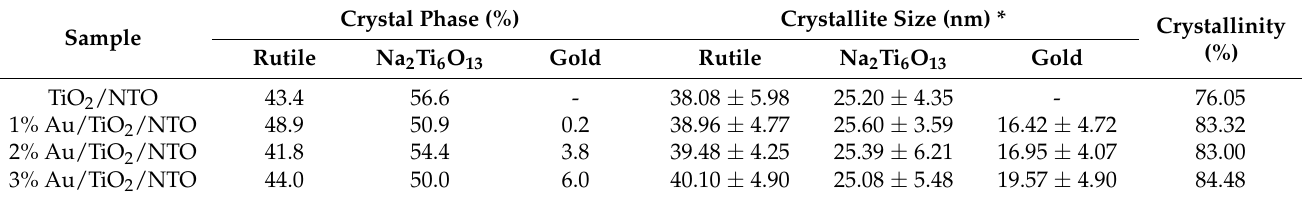
Table 1. Comparison of various composites of Na 2 Ti 6 O 13 and their applications.